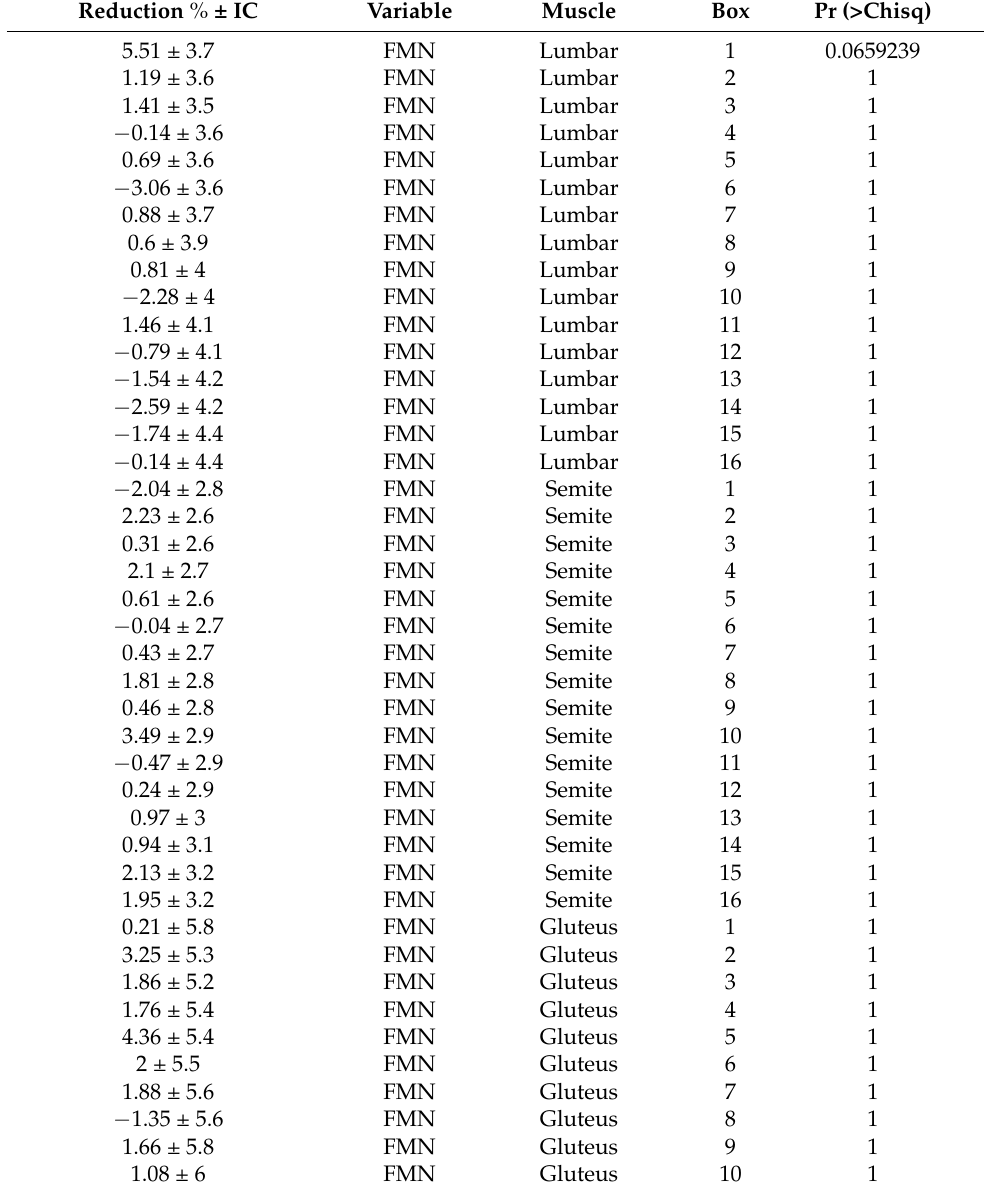
Table A4. The first column includes the percentile of reduction with the confidence interval. The second column shows the variable, in this case, the FMN; the third column, the muscle; and the fourth column, the number of box. Last value contains the p -value of the